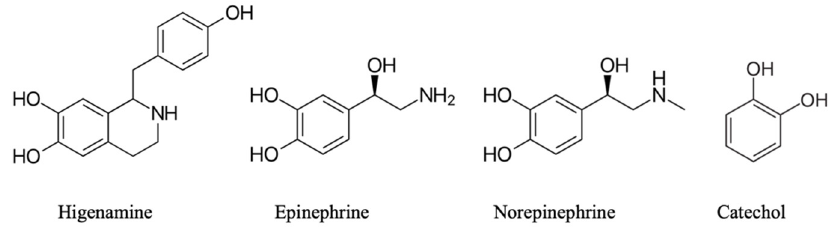
Figure 2. Higenamine, epinephrine, norepinephrine, and catechol structures.